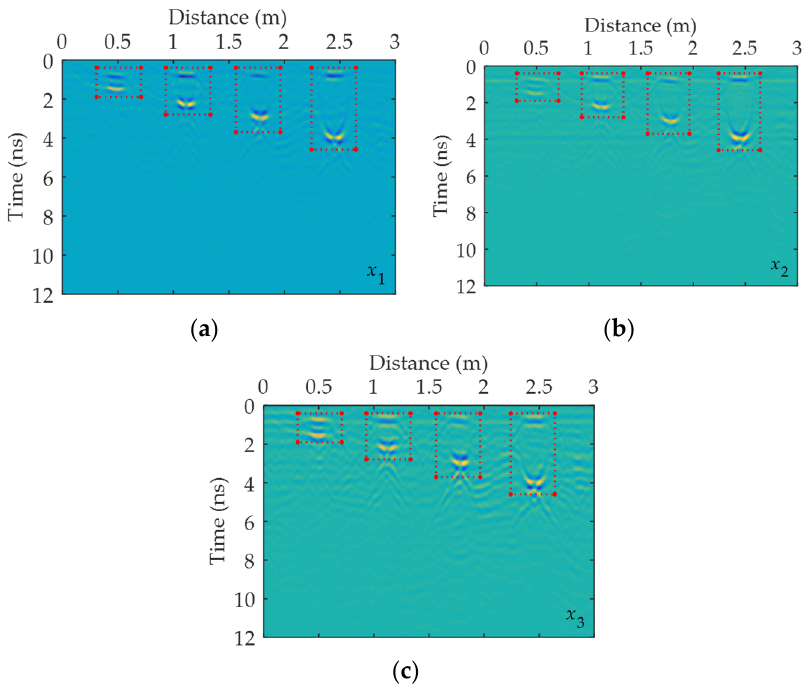
Figure 7. GPR profiles of three longitudinal survey lines after conventional processing: ( a ) survey line x 1 ; ( b ) survey line x 2 ; ( c ) survey line x 3